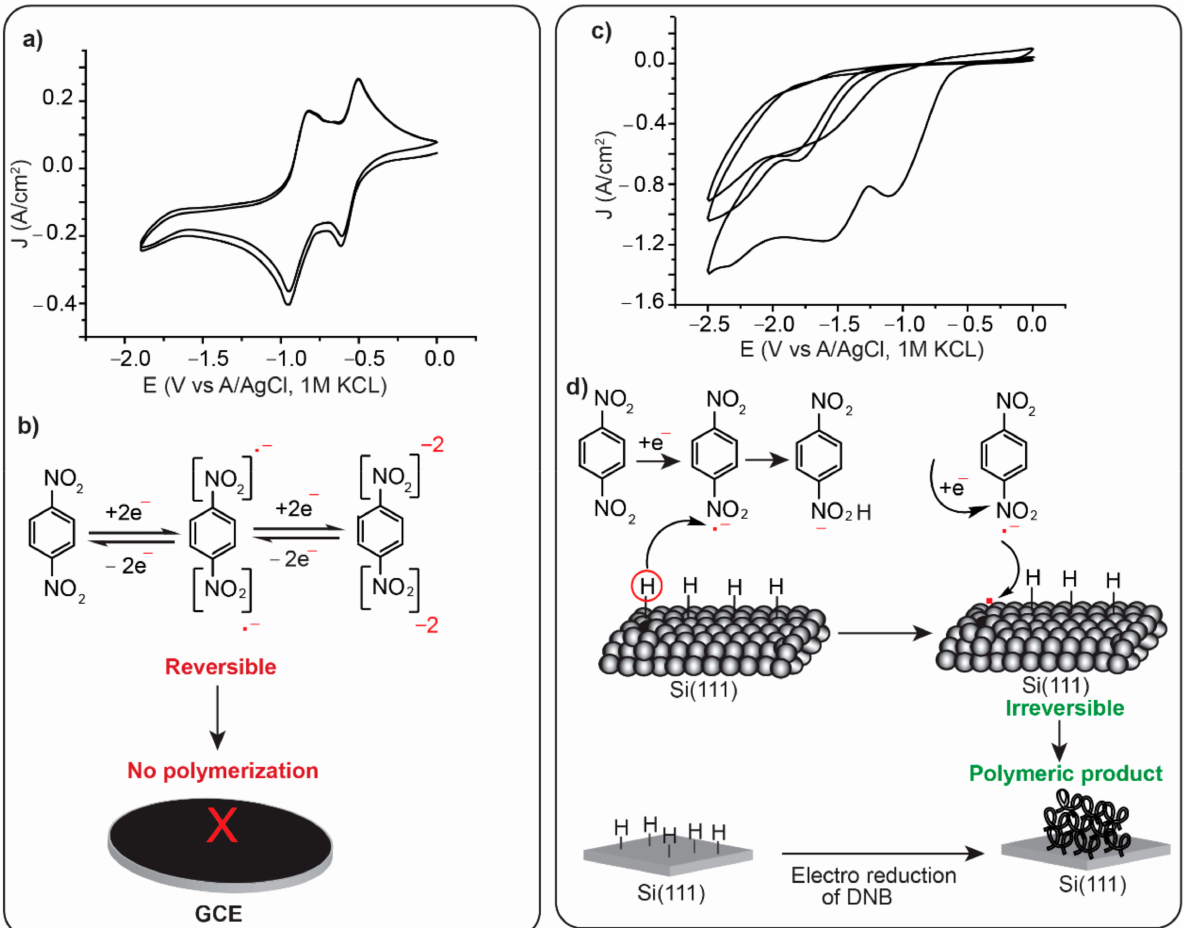
Figure 1. Redox properties of DNB in aprotic solvents on GCE and Si–H electrodes. ( a ) CV for 5 mM of DNB on GCE at a scan rate of 100 mV s − 1 with two reversible redox waves. ( b ) Schematic describing the oxidation/reduction reaction of DNB in aprotic solvents. ( c ) CV for 5 mM of DNB on Si–H electrode at a scan rate of 100 mV s − 1 , showing only two reduction waves at a relatively more negative potential and the waves disappear within the third cycle. ( d ) Schematic describing the formation of a molecular film on the Si–H surface upon reducing DNB in aprotic